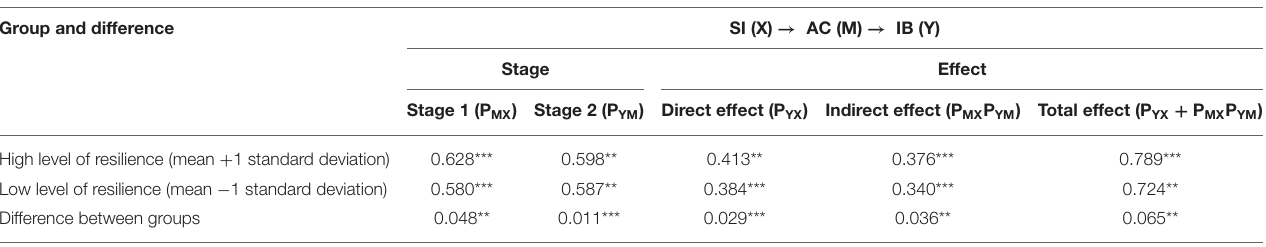
TABLE 8 | Analysis results of the moderated mediation model. Group and